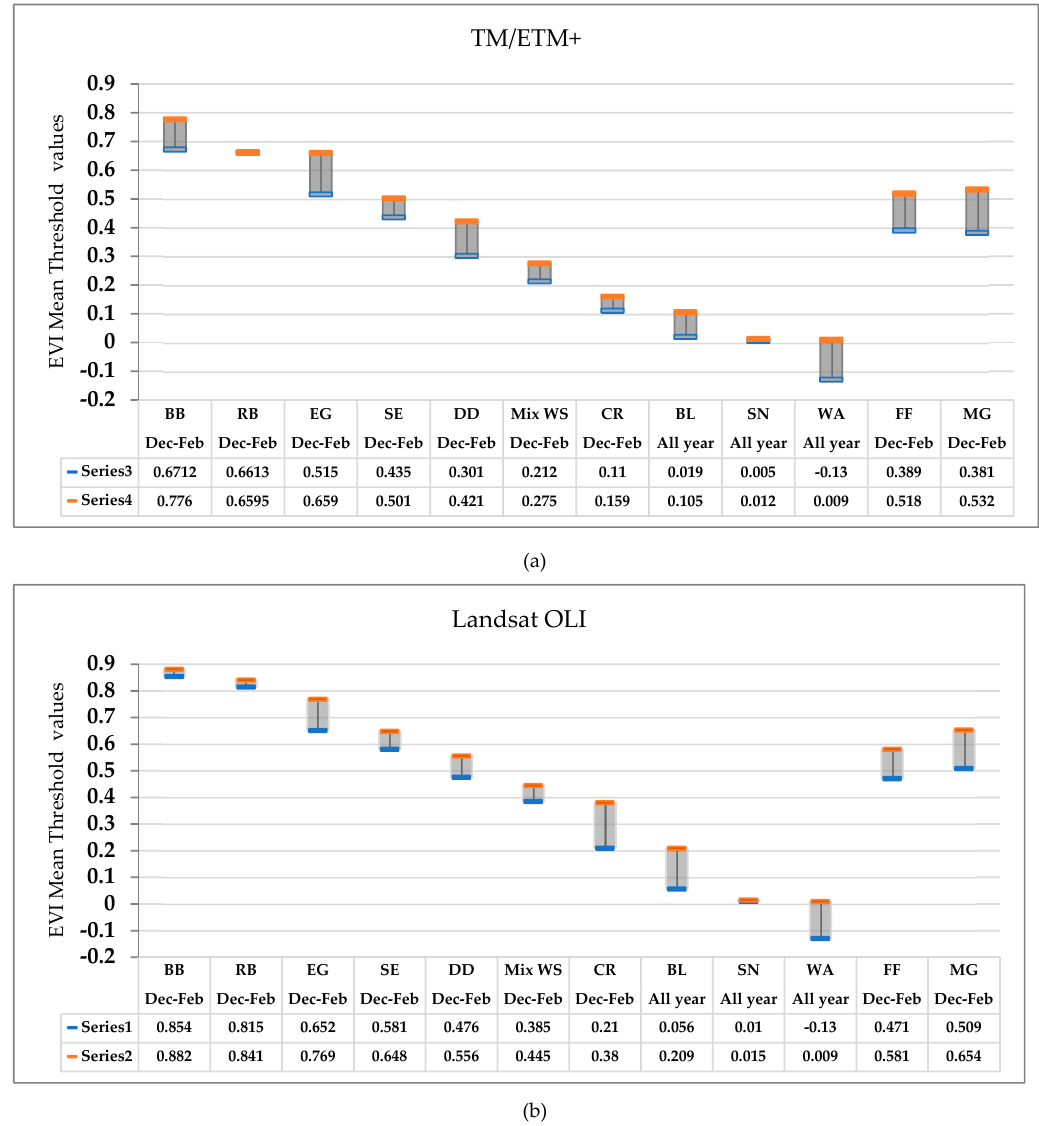
Figure 10. Minimum and maximum threshold values of the land cover categories during the mid-LSP phase based on the validation of 722 EVI phenology profiles between December and February from 2000–2003 and 2014–2017: ( a ) Shows the determined threshold values for the TM median EVI; ( b ) land cover threshold values for the OLI median EVI. The months represent a suitable period for selecting the remote sensing data to avoid the possibility of misclassification of land cover categories in the tropical regions. The non-forest categories, especially, BL, SN, and WA, can be mapped for any season, as they may not consider the mapping of the LSF and LFS seasons.